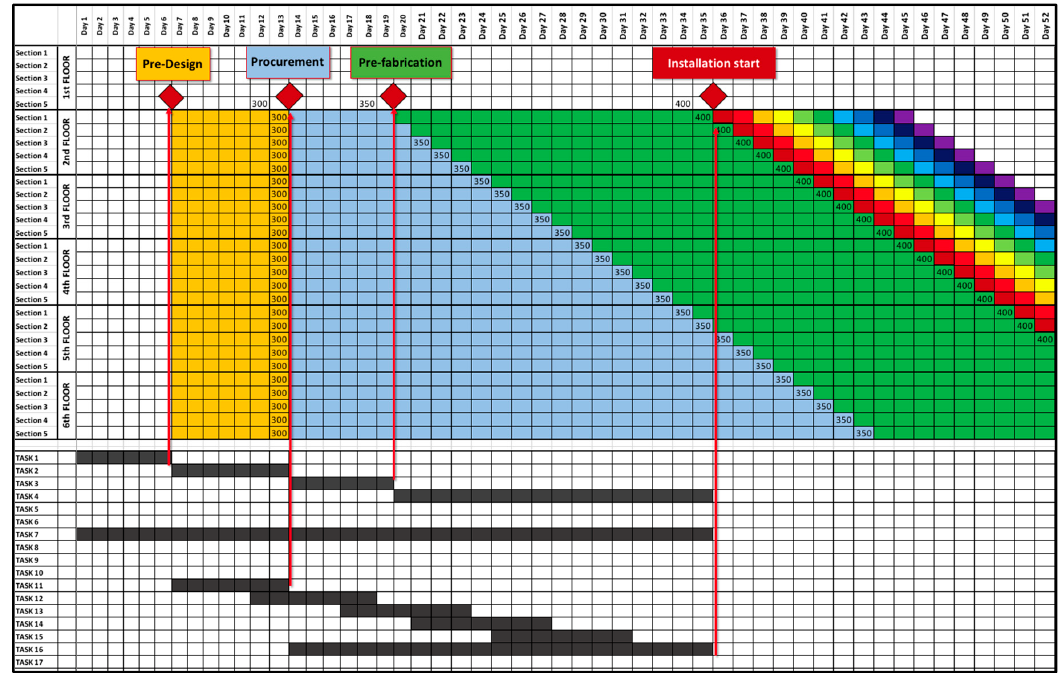
Figure 1. Linking the design LODs with the production takt time. Vertical axis presents locations and horizontal axis presents time.